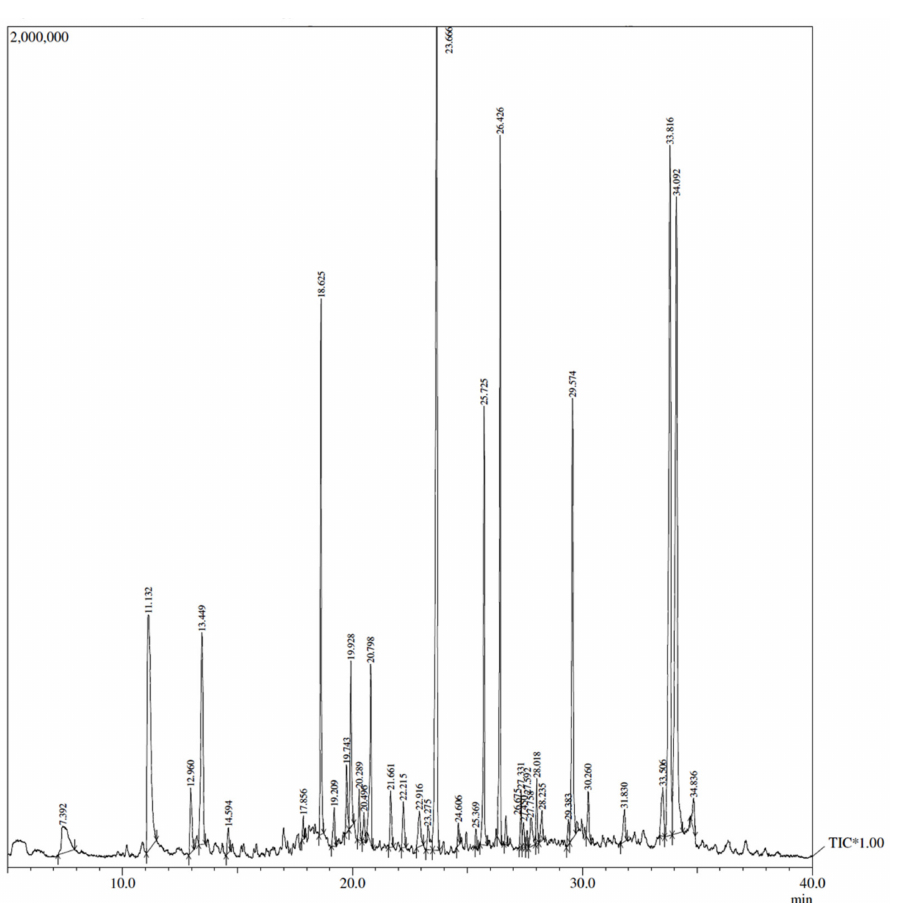
Figure 1. GC–MS chromatogram of Carum carvi showing peaks of individual constituents. 3.1.2. Inhibition of Lipid Peroxidation and DNA-Sugar Damage (In Vitro) Carum carvi showed concentration-dependent inhibition of LPO and DNA-sugar damage. With increasing concentration (20, 40, 60, 80, and 100 µ L) of Carum carvi extract, there was an increase in the inhibition of LPO and in DNA damage by 39%, 41%, 50%, 59%, and 63%, and by 14%, 23%, 36%, 45%, and 56%, respectively (Figure 2).